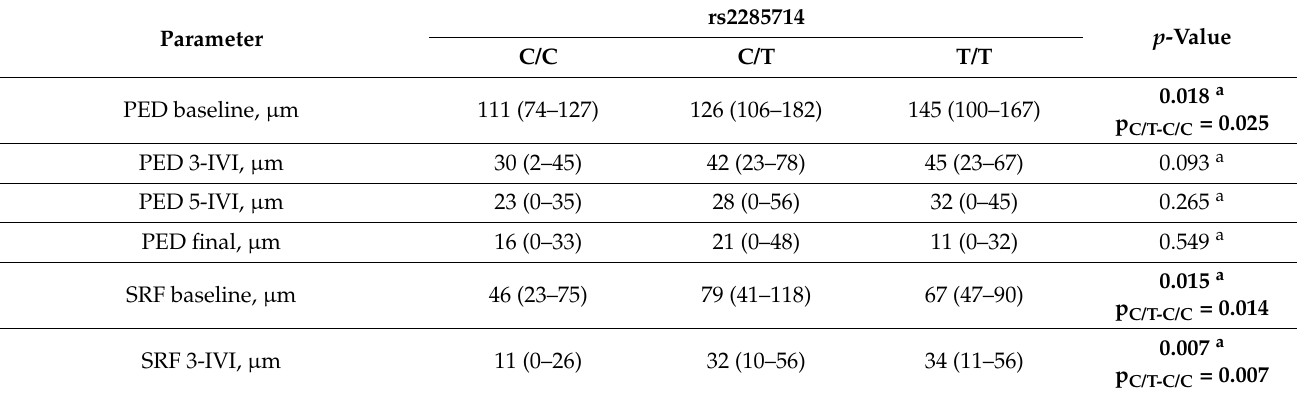
Table 6. Analysis of the OCT biomarkers depending on the rs2285714